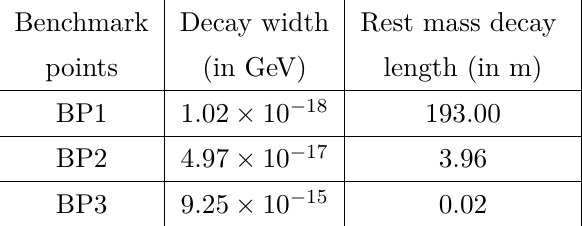
Table 6. Decay widths and rest mass decay lengths for the benchmark